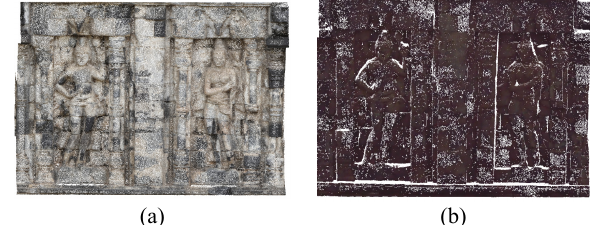
Figure 5. Example of a carving on the temple façade, resulting from (a) photogrammetry and (b) TLS.